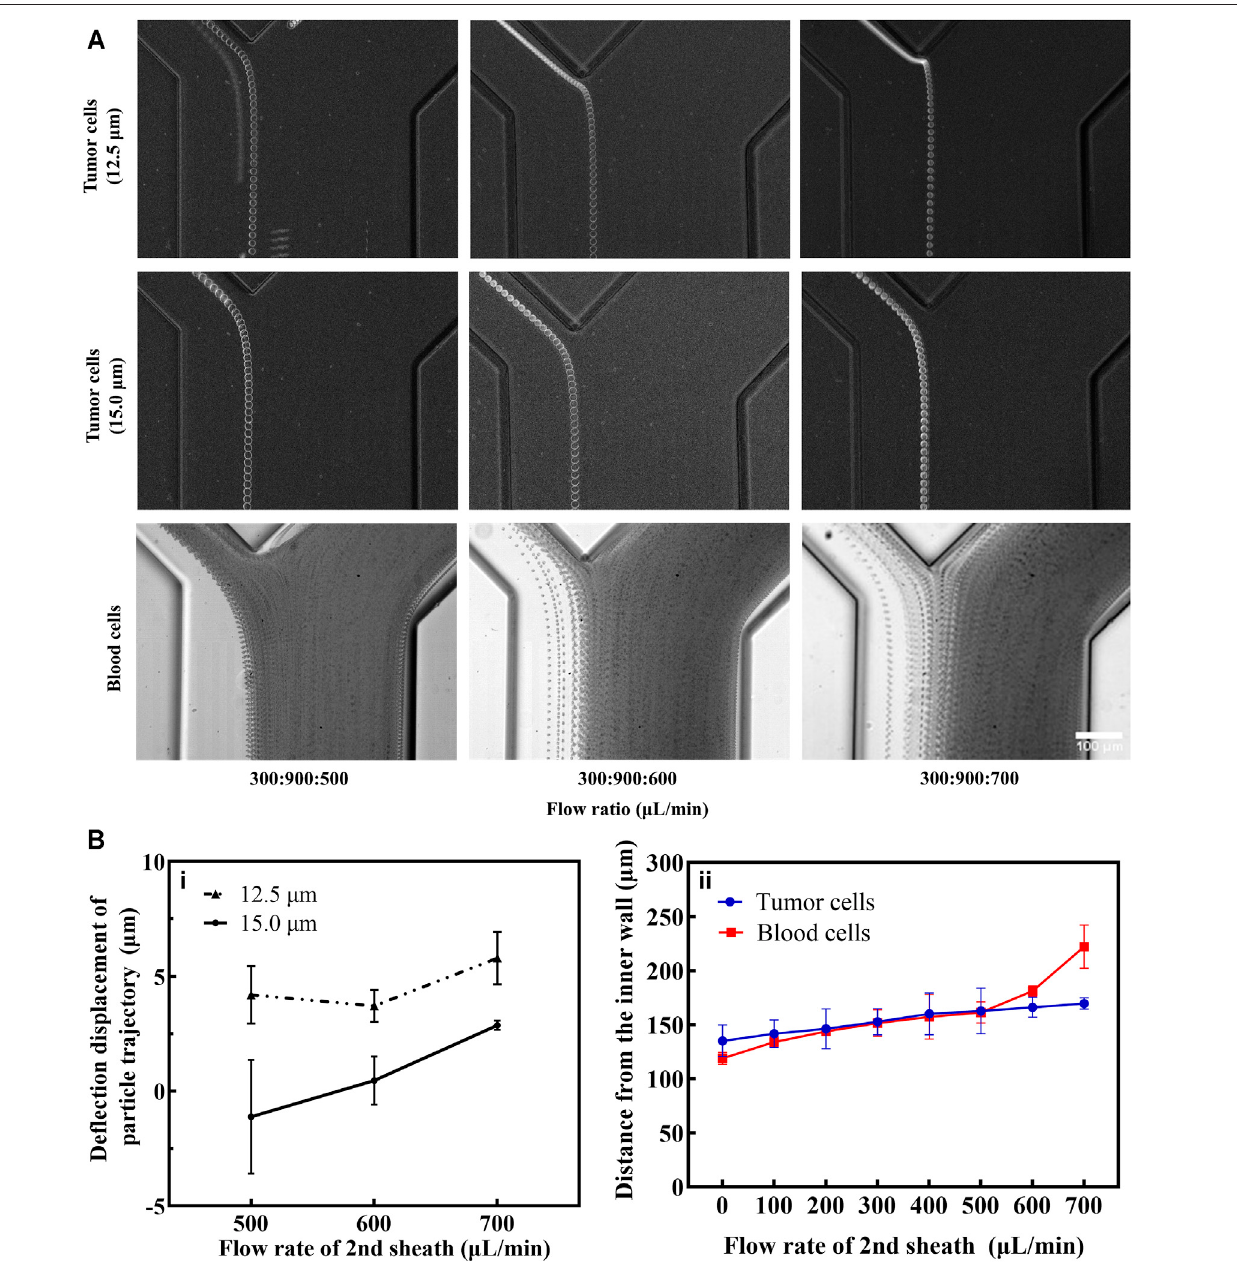
FIGURE 4 | Measurement and analysis of particle trajectories of CTCs and blood cells. (A) Tumor cells and blood cells movement trajectories under different fl ow rates for the 2nd sheath (ImageJ stacks processing). The scale bar is 100 μ m. (B) (i) : considering the bisector at the bifurcation as the reference line, the de fl ection displacementofdifferenttumorcellswasquantitativelymeasured(avaluegreaterthanzeromeansthatcellsarede fl ectedinthedirectionofthe1stwasteandviceversa). (ii) : comparison of the distance of small tumor cells and blood cells from the inner wall at different fl ow rates of the 2nd sheath.